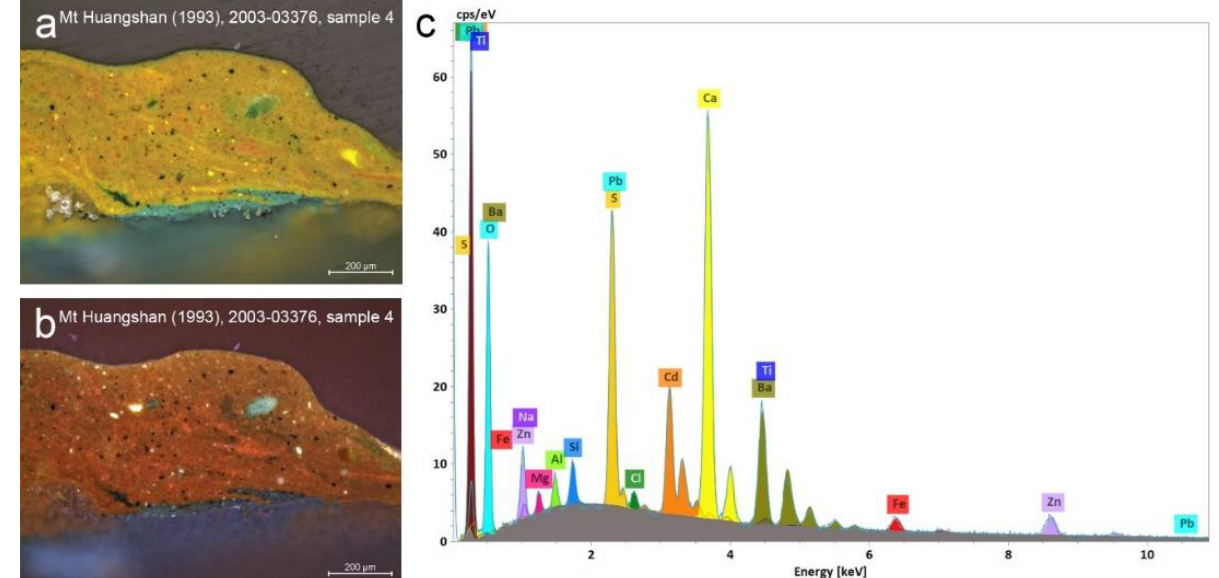
Figure 12. Optical microscopy images of the paint cross-section of sample 4, extracted from Mount Huangshan , 1993, photographed in: ( a ) VIS and ( b ) UV. The corresponding SEM-EDS spectra of the yellow paint ( c ). Red fluorescence of yellow paint and strong Cd and S signals combined with Ba and Zn suggests the use of cadmium yellow or cadmopone or zinc-modified light cadmium yellow.